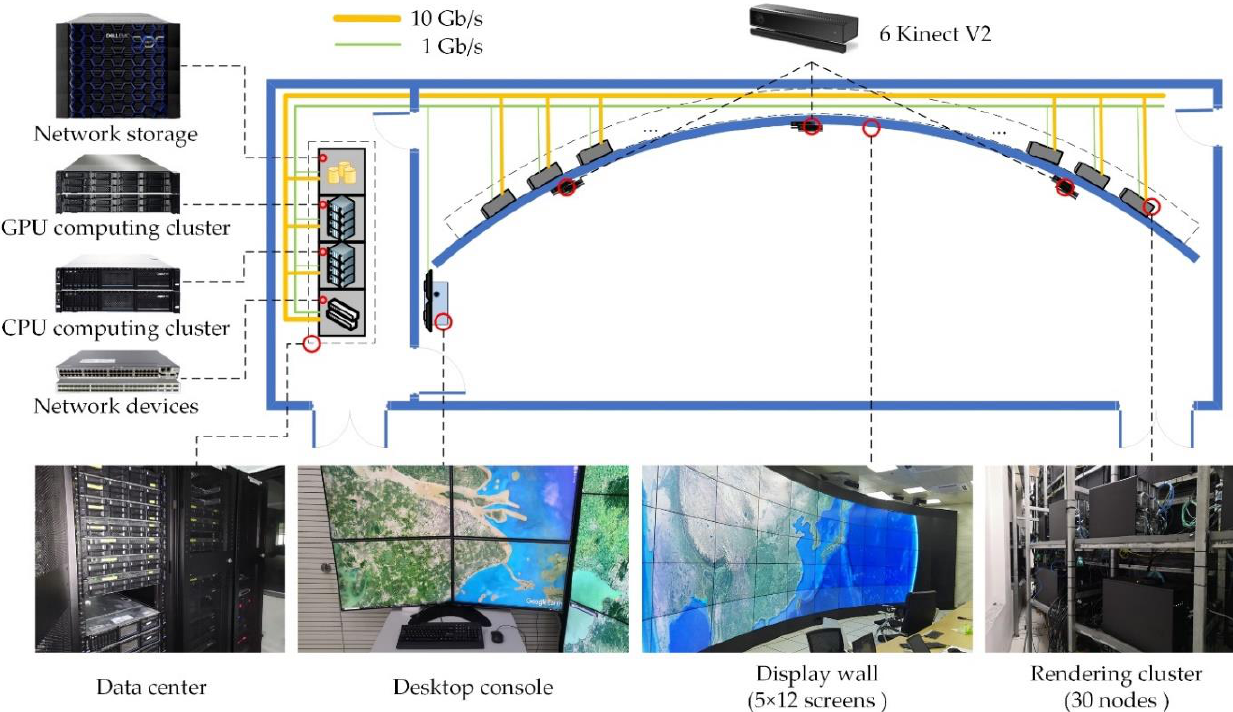
Figure 1. System structure of SHU-VAS.